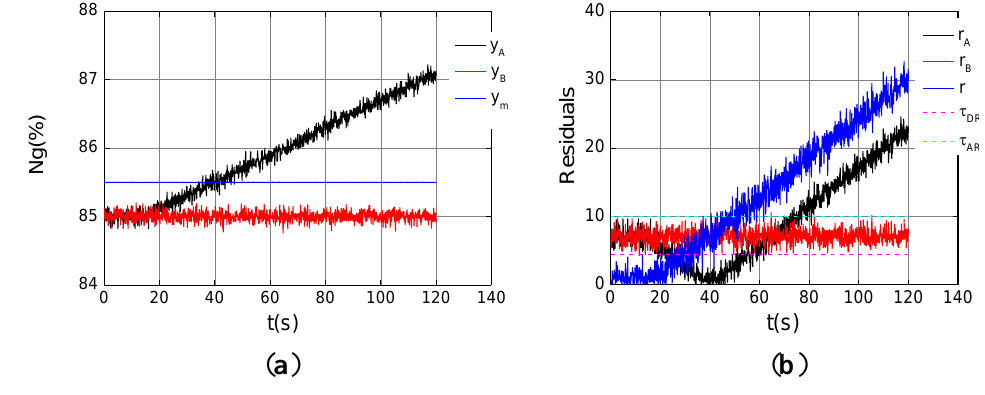
drift fault under the steady state of ng % = g